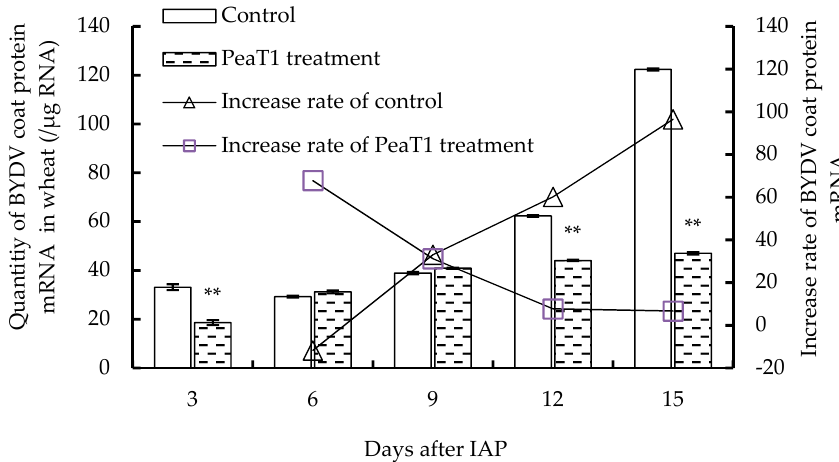
Figure 1. Effect of PeaT1 on the quantity of barley yellow dwarf virus (BYDV) coat protein mRNA in wheat. Note: two asterisks stand for the significant difference in BYDV quantity between control and PeaT1 treatment, p < 0.01.